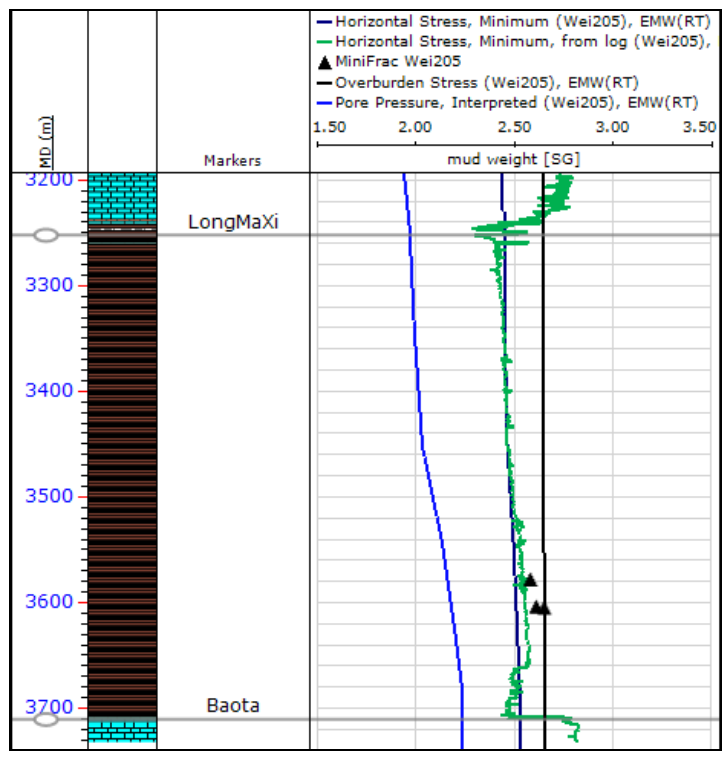
Figure 15. S hmin profile of W205.